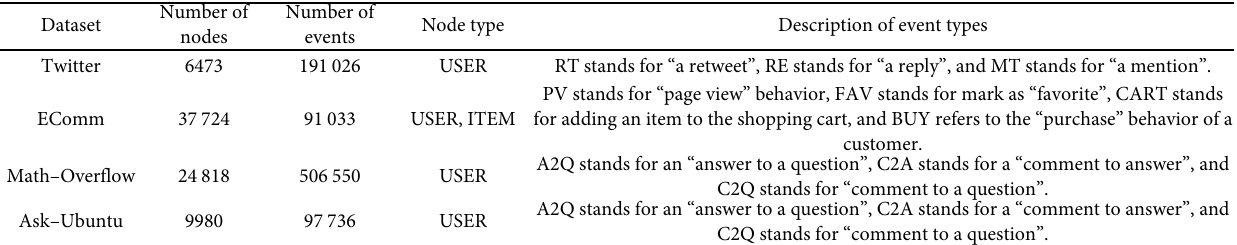
Table 1 Statistics of